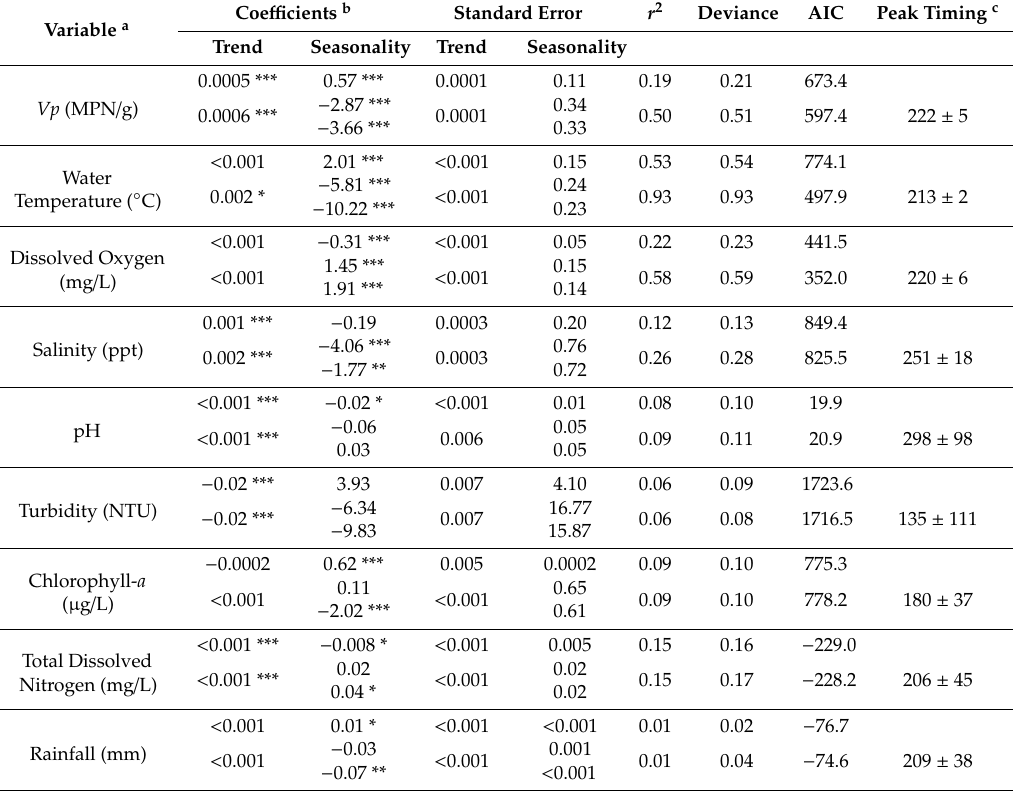
a Variables are shown for Model 1, top row and Model 2, two bottom rows for sine and cosine terms; b the significance of coe ffi cients is indicated as *** 0.001, ** 0.01, and * 0.1; c peak timing estimates are represented by the mean and standard error values; for two parameters, dissolved oxygen (DO) and total dissolved nitrogen (TDN), the estimates reflect the seasonal nadir. AIC, Akaike’s Information